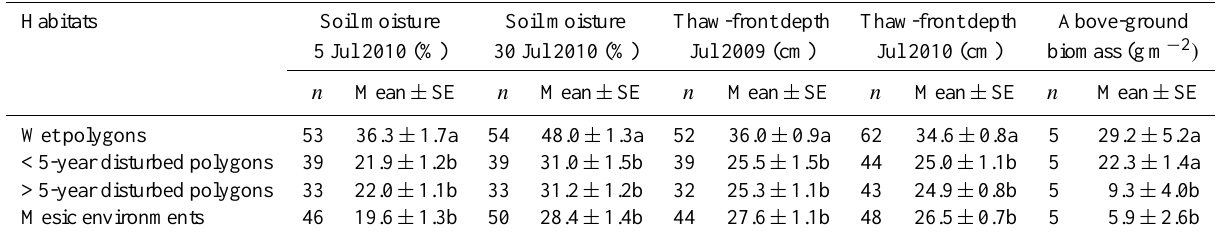
Table A1. Sample sizes and means ( ± SE) of soil moisture, thaw-front depth and graminoid above-ground biomass in the four habitats studied in the Qarlikturvik valley of Bylot Island, Nunavut. Letters refer to post hoc contrasts that were carried out using the LSMEANS statement and Bonferroni adjustment (procedure MIXED, SAS 9.4). For a given variable, different letters indicate significant differences among